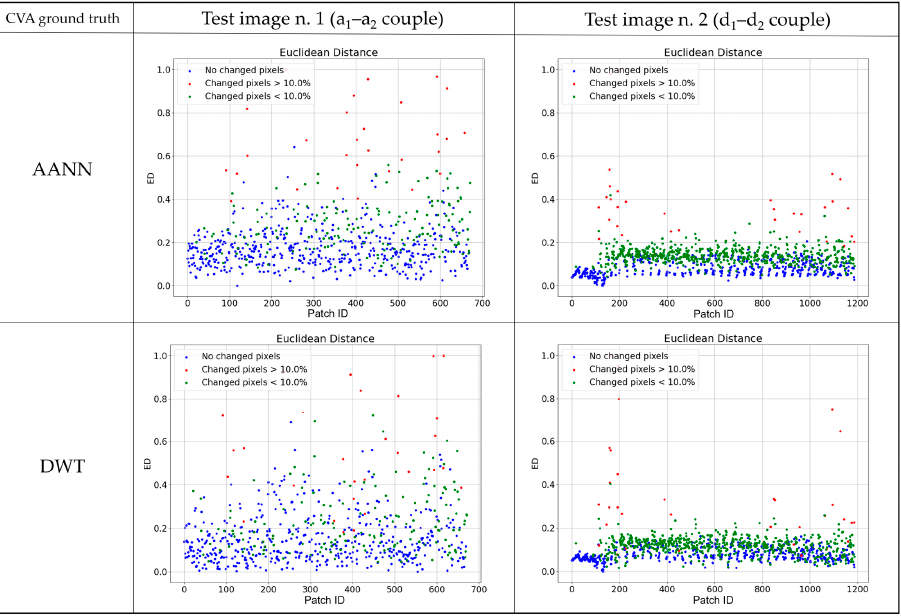
Figure 14. ED value ( y -axis) related to each patch ( x -axis) for test image 1 in Figure 11(a 1 ,a 2 ) ( left ) and test image 2 in Figure 11(d 1 ,d 2 ) ( right ). Each marker is colored according to the change condition in the CVA ground truth patch.